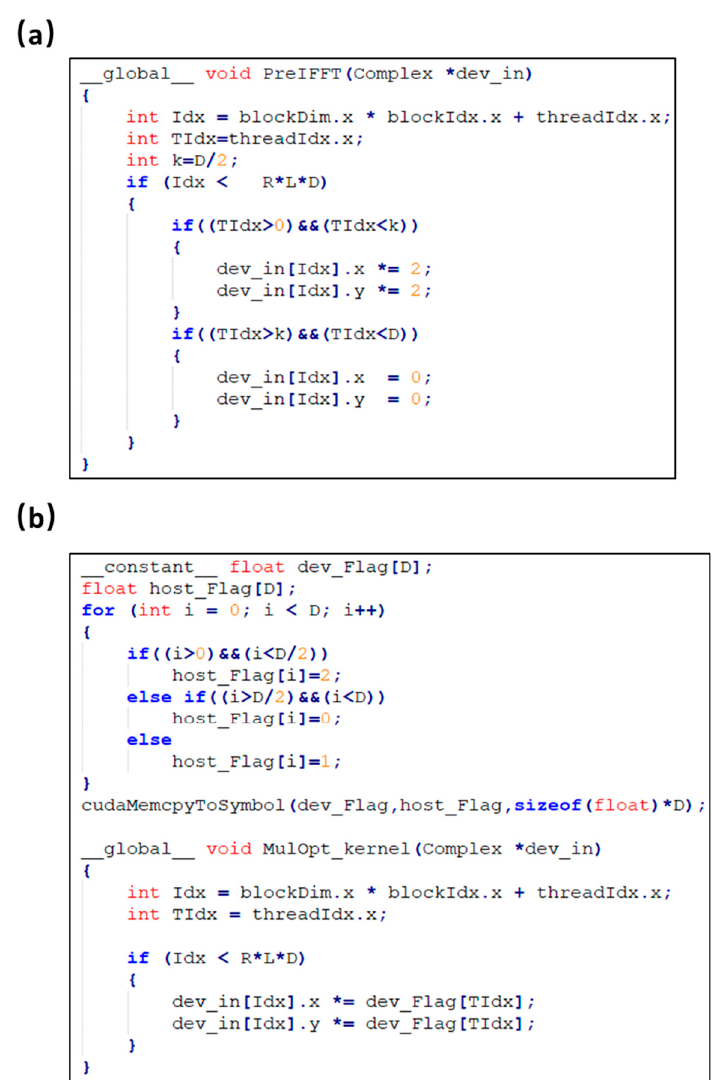
Figure 8. Kernel function of multiplication in Hilbert transformation with CUDA. (a) Initial implementation. (b) Optimized implementation. Idx, thread address index; TIdx, thread index in a block.